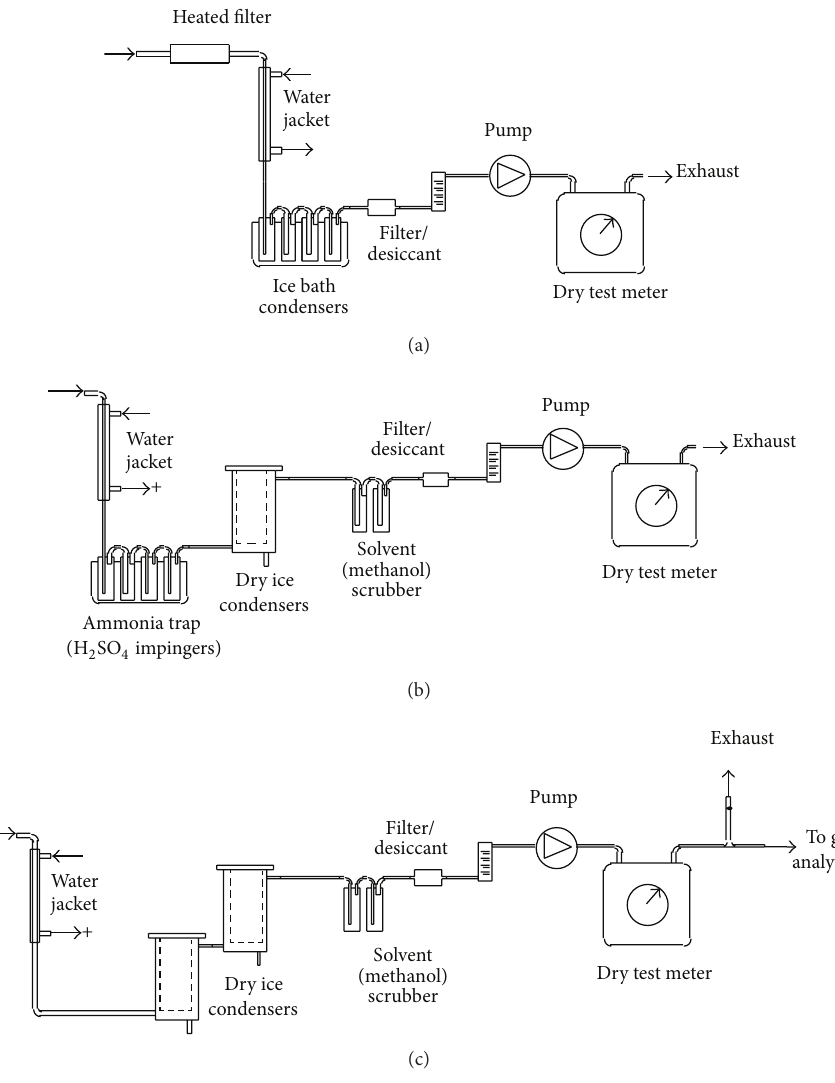
Figure 2: (a) Alkali sampling train; (b) ammonia sampling train; (c) tar sampling